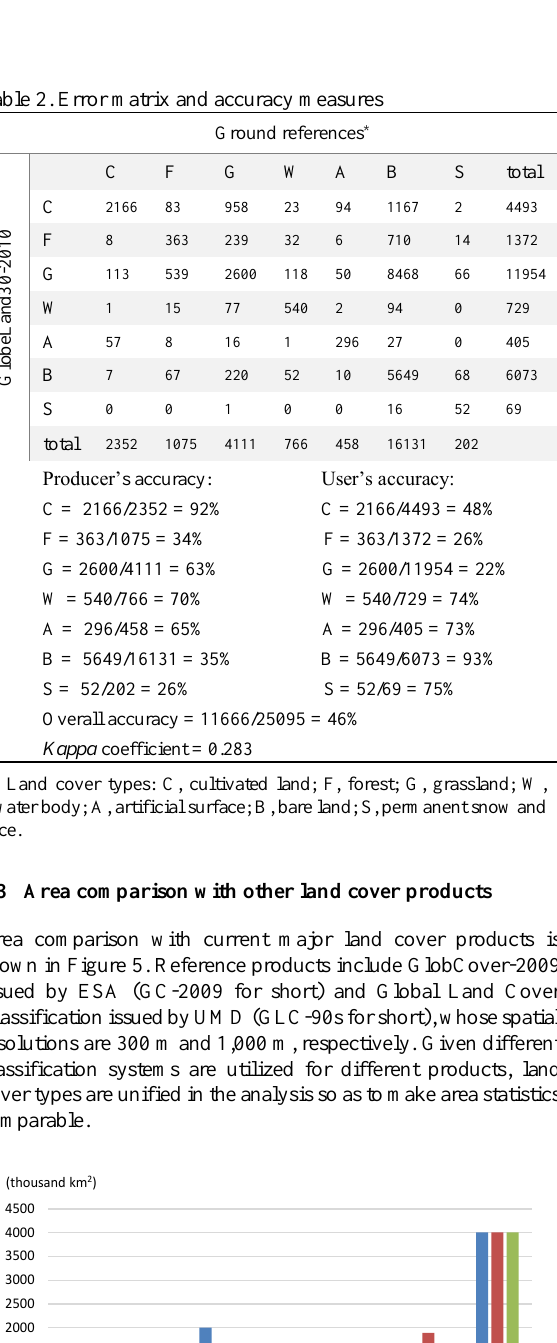
Figure 4. Proportions of cross-validated samples by land cover type.